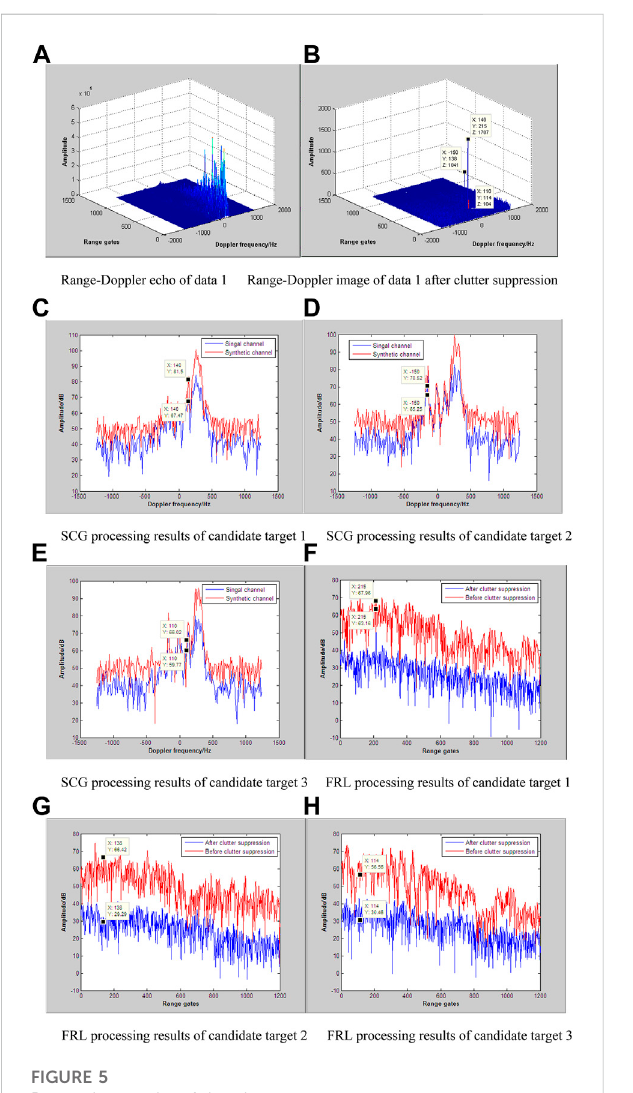
FIGURE 5 Processing results of data 1.